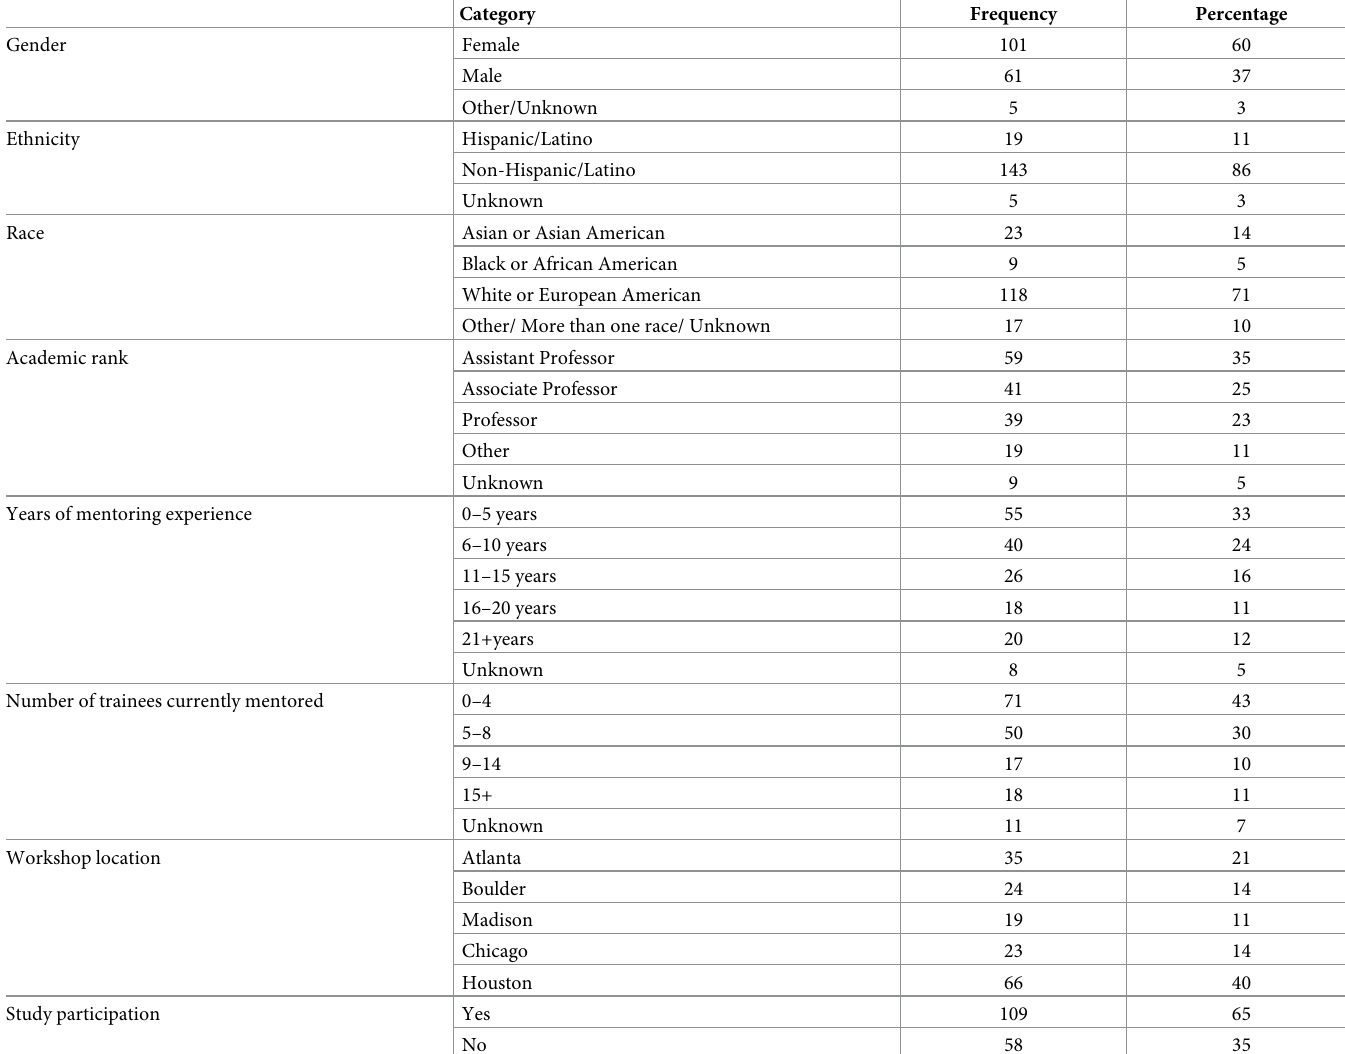
Table 2. Workshop participant demographics, Years 1 & 2 (N =